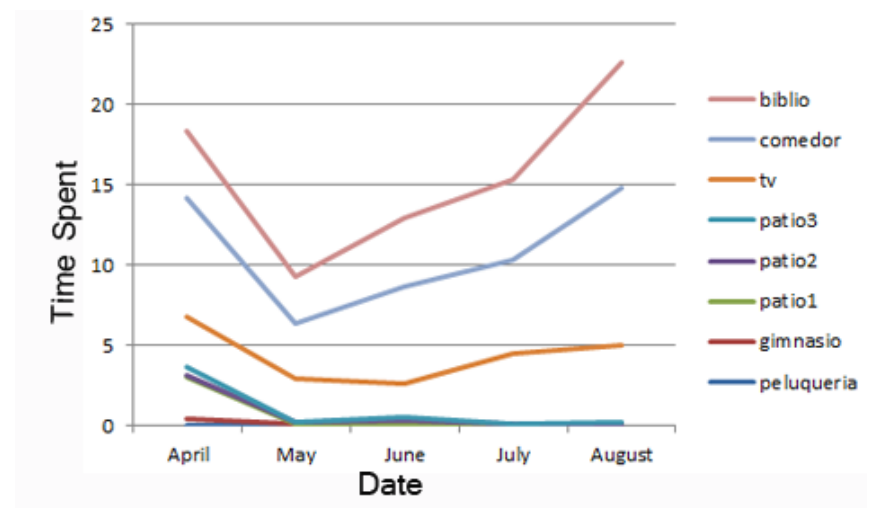
Figure 7. Evolution of favorite